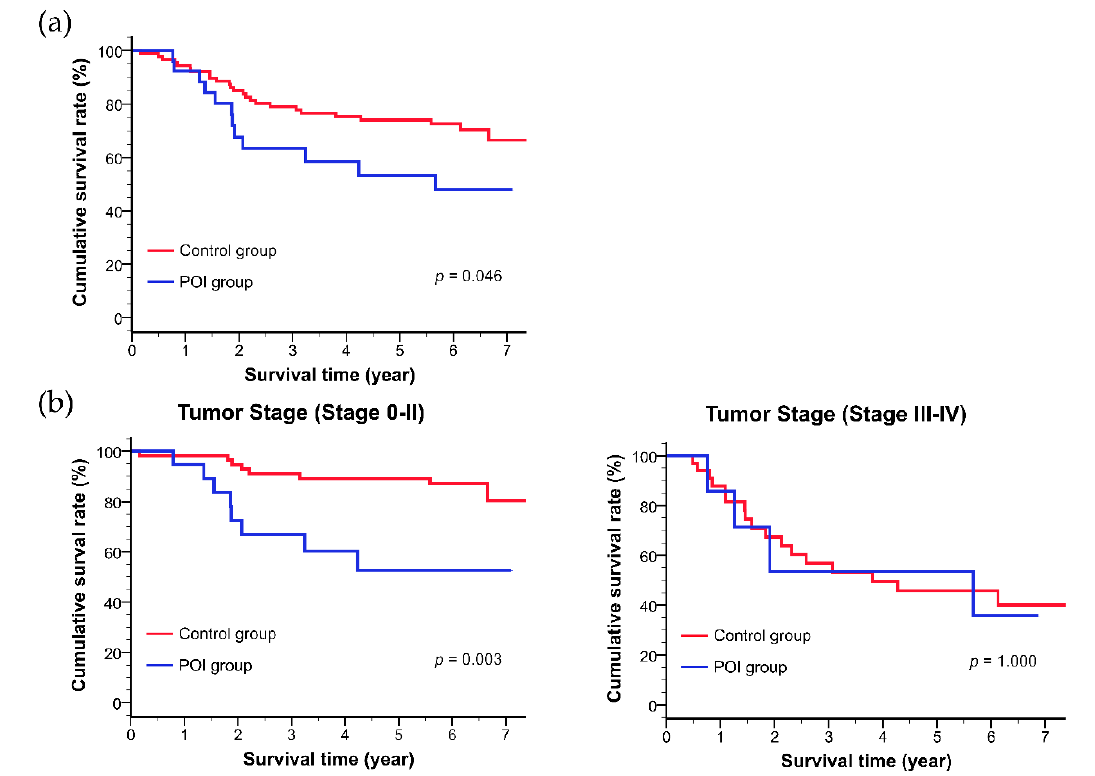
Figure 4. Kaplan–Meier estimates of the overall survival based on postoperative oral intake. ( a ) Overall survival, ( b ) stratification of patients by tumor stage (Stages 0–II and III–IV). Differences between the two groups were analyzed using the log-rank test and Bonferroni adjustment for multiple comparisons.